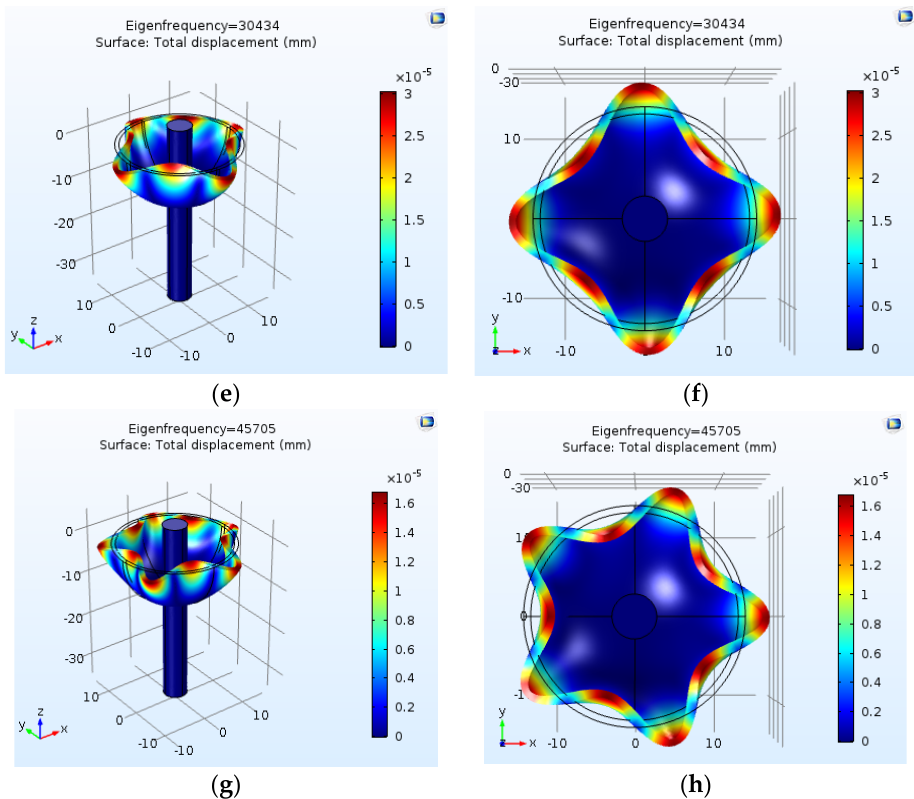
Figure 13. Display of placement and excitation frequency in the fourth and fifth modes. ( a ) Second mode—perspective; ( b ) second mode—view from the top; ( c ) third mode—perspective; ( d ) third mode—view from the top; ( e ) fourth mode—perspective; ( f ) fourth mode—view from the top; ( g ) fifth mode—perspective; ( h ) fifth mode—view from the top.